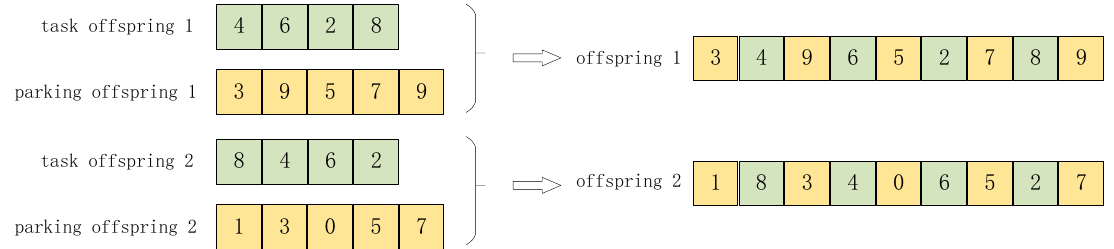
Figure 6. Paired combinations of the chromosomes after the crossover operation.